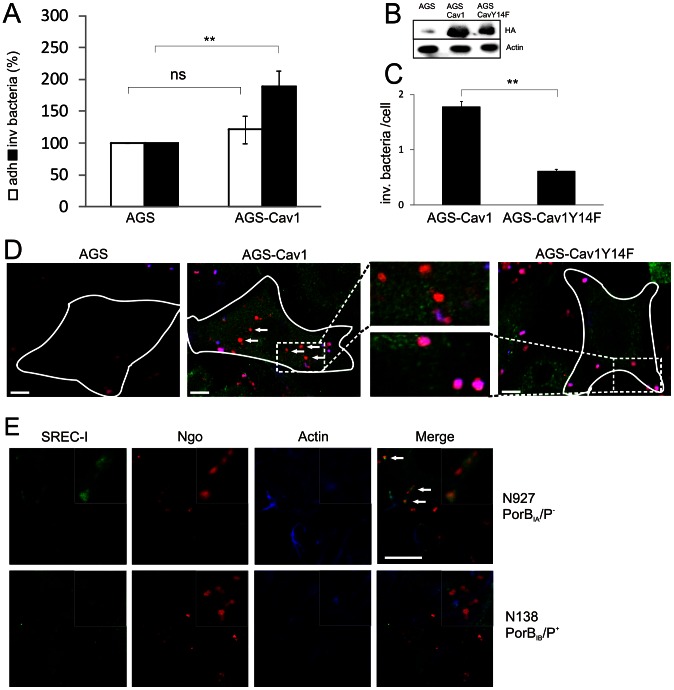
Caveolin is required for N927 invasion.(a) AGS cells (AGS) and a transgenic AGS cell line expressing caveolin-1 (AGS Cav1wt) were infected with N927 (PorBIA, P−) at MOI 50. Adherent (adh.) and intracellular (inv.) bacteria were quantified by gentamicin protection assays. The number of adherent and invasive bacteria of AGS cells was taken as 100%. The graph shows mean values ± SD of three independent experiments done in duplicates. White bars: adherent bacteria; black bars: intracellular bacteria p<0.01: ** (b) AGS cell expressing an HA-tagged wt (AGS Cav1wt) or mutant (AGS Cav1Y14F) caveolin were analyzed by Western blot using an HA antibody. (c) Intracellular N927 (PorBIA, P−) of the experiment shown in figure (D) were quantified by differential immunofluorescence. p<0.01: **. (D) AGS cells were transiently transfected with HA-tagged Cav1 (AGS-Cav1) or Cav1Y14F (AGS-Cav1Y14F) and infected with N927 at MOI 25. Adherent (pink) and intracellular (red; white arrows) bacteria were detected by differential immunofluorescence. Caveolin expression was visualized with an HA antiserum and a Cy2-conjugated secondary antibody (green). Scale bar: 10 µm (E) SREC-I is recruited to N927 (PorBIA, P−)(white arrows), but not N138 (PorBIB, P+). Chang cells were infected with SNARF-labeled bacteria at an MOI 25. SREC-I was detected with a polyclonal serum against SREC-I and a Cy2-conjugated secondary antibody. Co-localisation of SREC-I and gonococci was analyzed by confocal fluorescence microscopy. Scale bar: 10 µm.